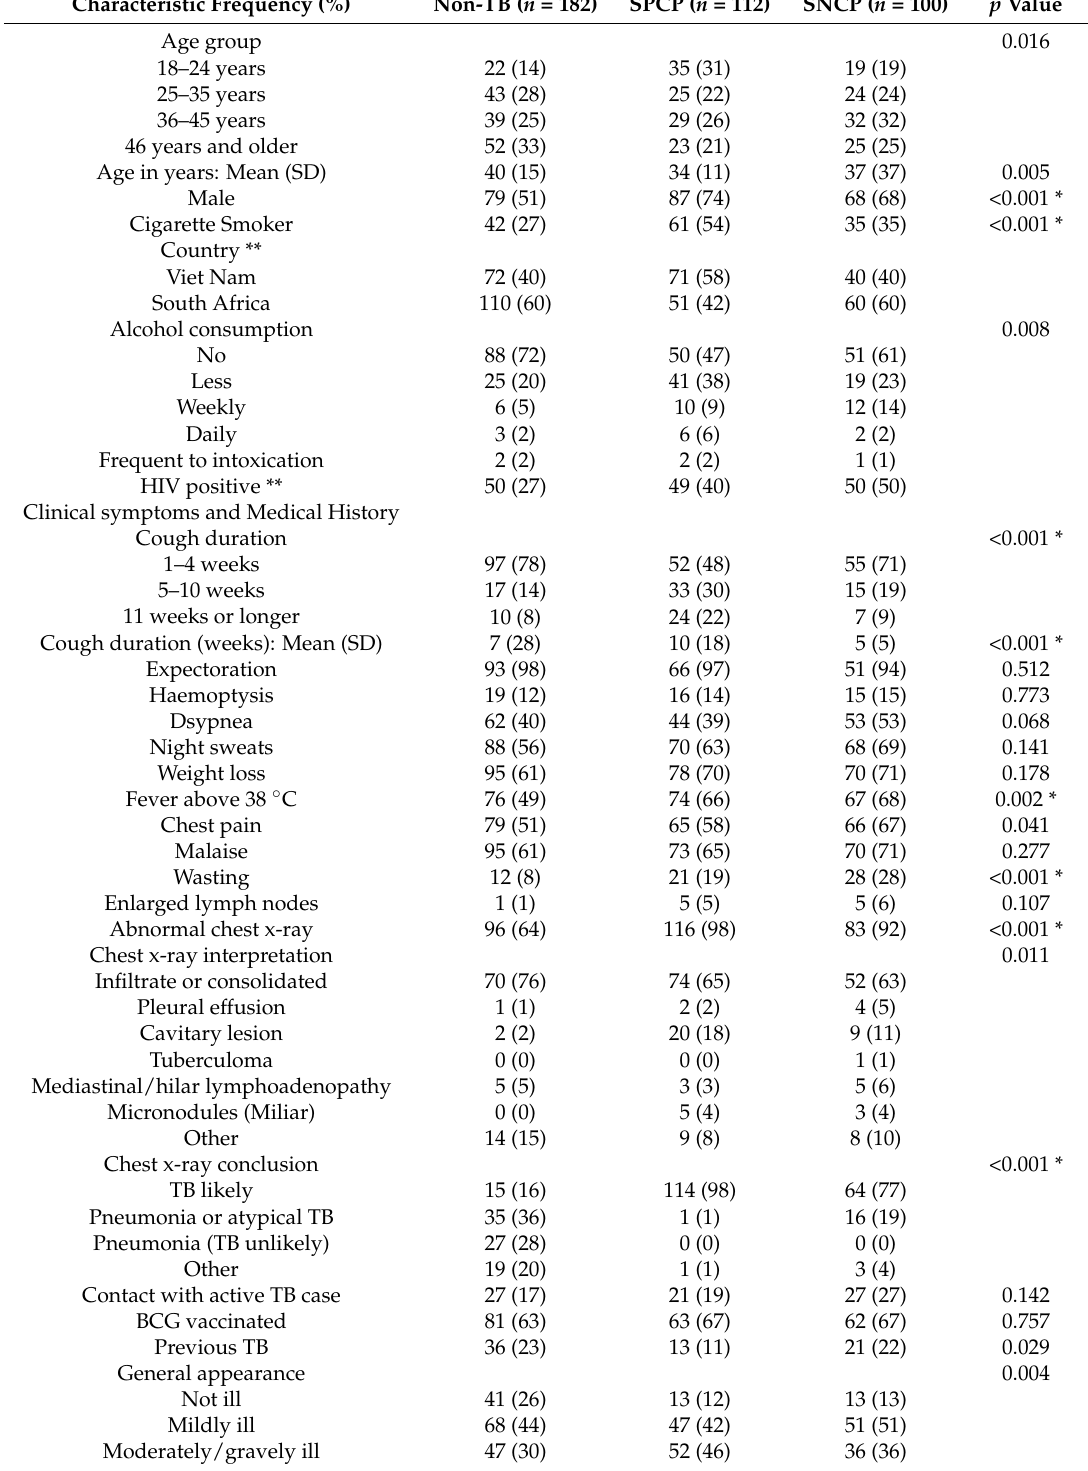
Table 1. Demographic and clinical characteristics of the study